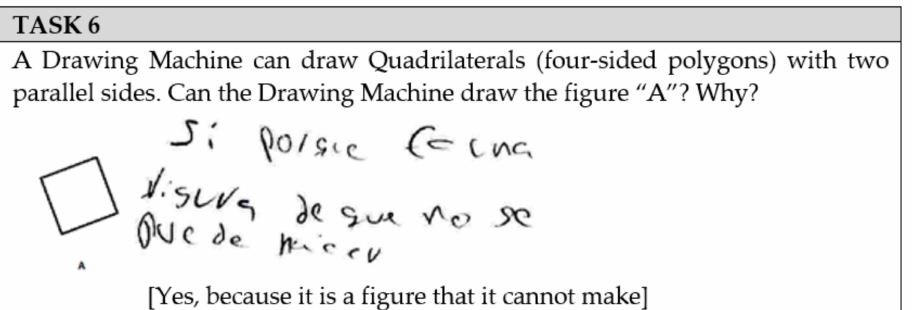
Figure 10. The answer given by G1S1 to the task of recognizing if a figure is an example of a polygon class (it can have two different labels).